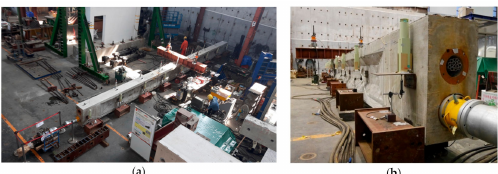
Figure 3. Three-point bending tests on a PCI girder conducted in the laboratory of NCREE, Taiwan [50]: ( a ) indoor test rig; ( b ) application of a FBG-Di ff erential Settlement Measurement (DSM) liquid-level system for vertical deflection measurements along the span. Copyright © 2019 Elsevier Ltd. Adapted with permission.